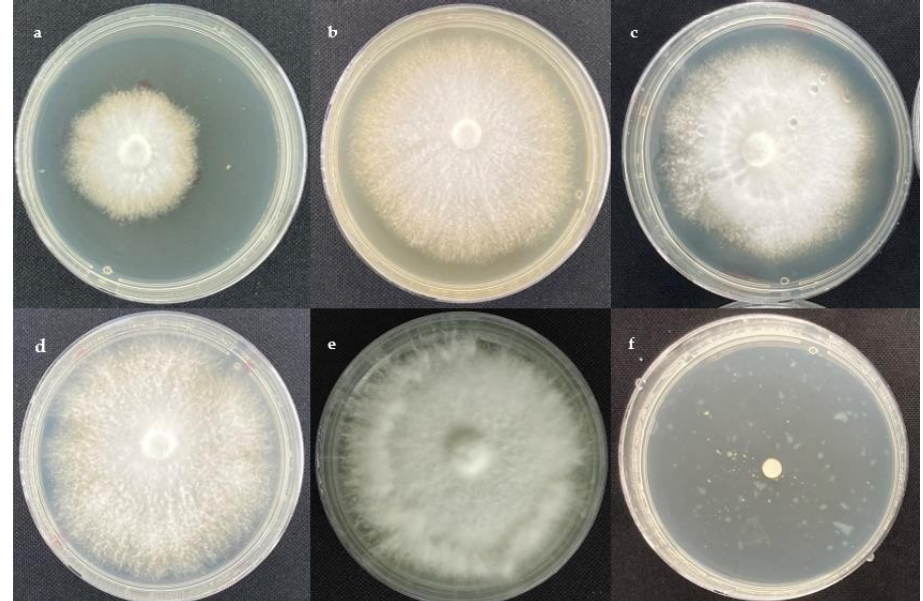
Figure 1. Poisoned culture assay against M. perniciosa after 14 days of incubation. ( a ) T. spirale (C10) at 10 µ g/mL, ( b ) T. harzianum (C4A) at 1000 µ g/mL, ( c ) T. sp. (C3A) at 100 µ g/mL, ( d ) negative control DMSO, ( e ) negative control PDA, and ( f ) positive control: azoxystrobin at 10 µ g/mL.